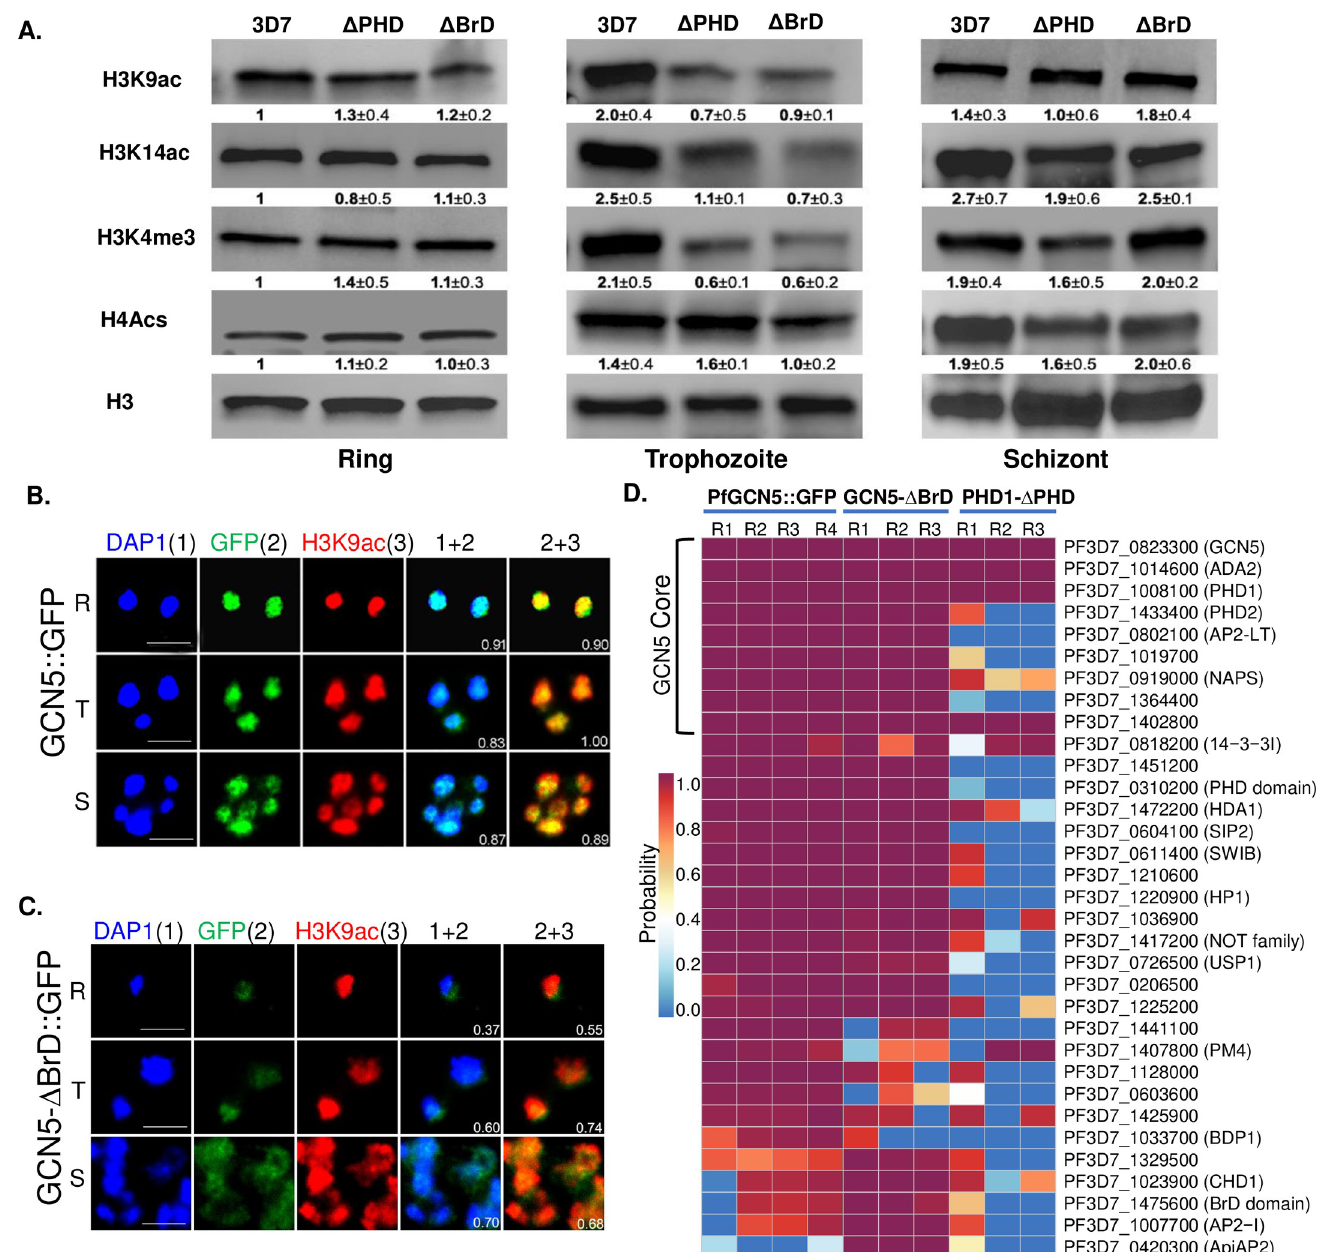
Fig 3. Domain deletions affect the abundance and localization of active histone marks and the integrity of the PfGCN5 complex. (A) The levels of active histone marks in 3D7, PfGCN5- Δ BrD::GFP ( Δ BrD), and PfPHD1- Δ PHD::GFP ( Δ PHD) parasite lines. Histones were purified from the ring, trophozoite, and schizont stages, and detected by Western blots with specific antibodies against the modified histones H3K9ac, H3K14ac, H3K4me3, and H4Acs. Anti-H3 antibodies were used for loading control. The Western blots were performed in three biological replicates, and the band intensities were determined using a densitometer. The number underneath each band indicates the fold change ± standard deviation between the ratio of the corresponding histone mark normalized to the H3 control. The ratios in 3D7 at the ring stage were set as 1. (B, C) Co-localization of full-length PfGCN5 (GCN5::GFP) (B) or truncated PfGCN5 (GCN5- Δ Brd::GFP) (C) with H3K9ac and DAPI by IFA with anti-GFP and H3K9Ac antibodies. Note the expansion of the truncated PfGCN5- Δ BrD::GFP and H3K9ac beyond the periphery of the euchromatin areas demarcated by DAPI staining. (D) Effects of domain deletions in PfGCN5 and PfPHD1 on complex integrity. Proteins were pulled down from the trophozoite nuclear extracts of the PfGCN5::GFP, GCN5- Δ BrD::GFP, and PHD1- Δ PHD::GFP parasite lines and identified by LC-MS/MS. R1, R2, R3 and R4 indicate individual repeats of the experiment. Shown here are proteins passing the threshold of SAINT (probability > 94% and FDR < 1%). The nine PfGCN5 complex core subunits were all detected in the IPs of PfGCN5::GFP and GCN5- Δ BrD::GFP, whereas only four of the core subunits were identified in the IPs of PHD1- Δ PHD::GFP.